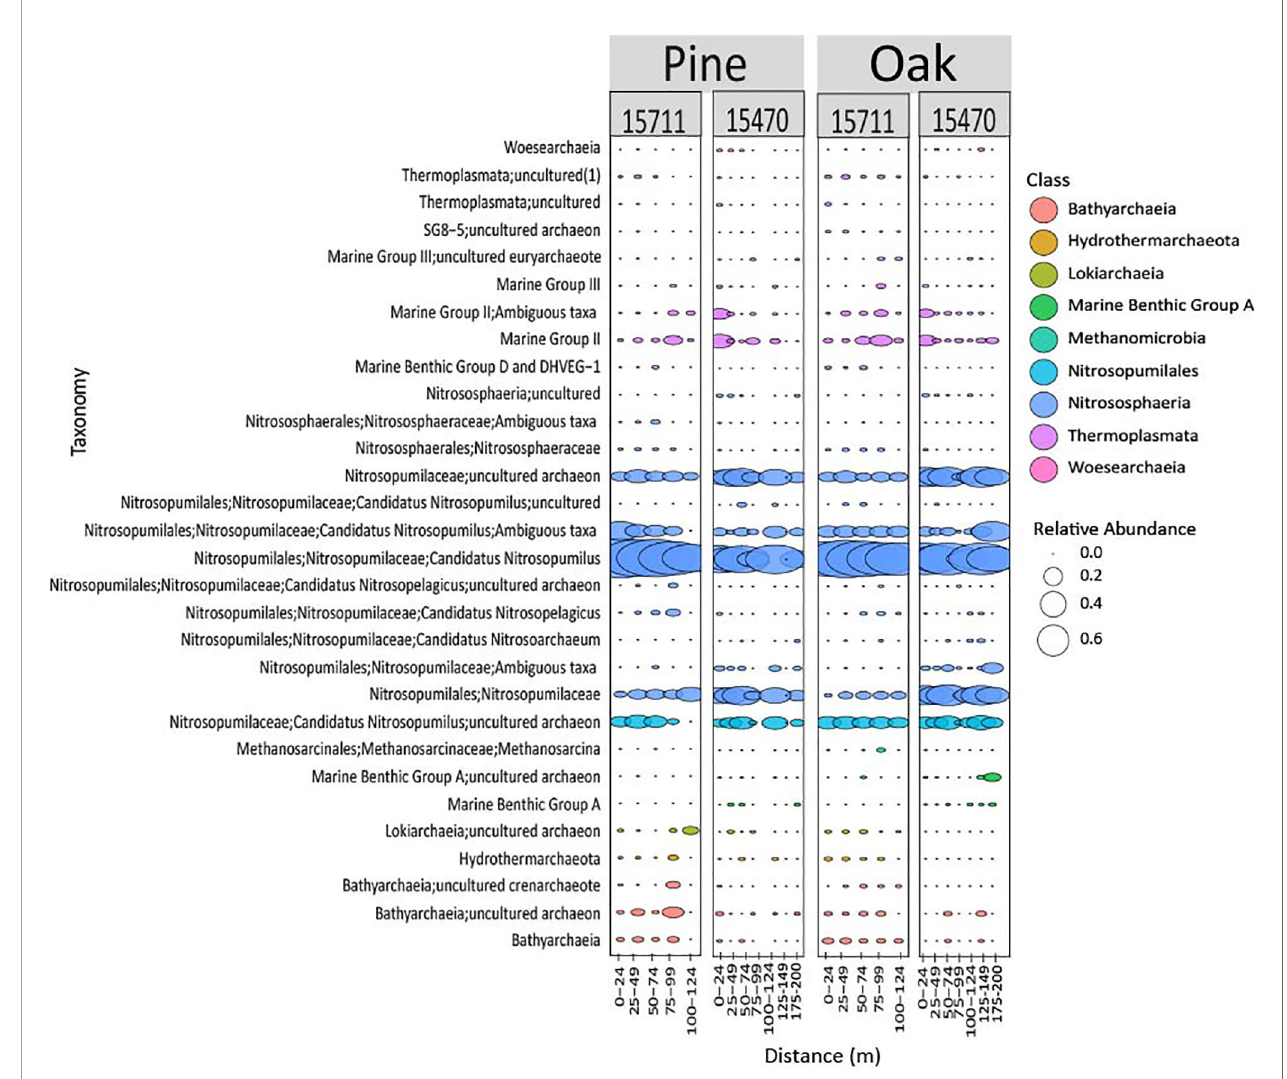
FIGURE 5 | Bubble plot representing the 30 most abundant archaeal taxa from both sites and wood types. Samples are grouped in distance categories spanning 25